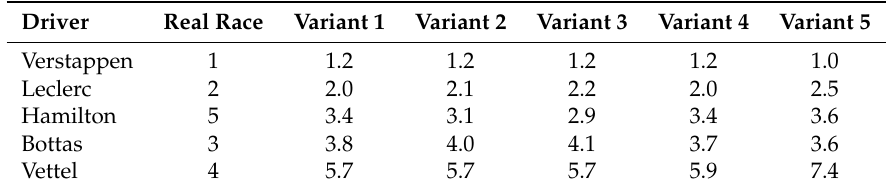
Table 18. Real and average result positions of the top five drivers after 10,000 simulation runs of the 2019 Austrian Grand Prix. Five different variants of race strategy determination are compared. Probabilistic influences were activated, FCY phases were deactivated.